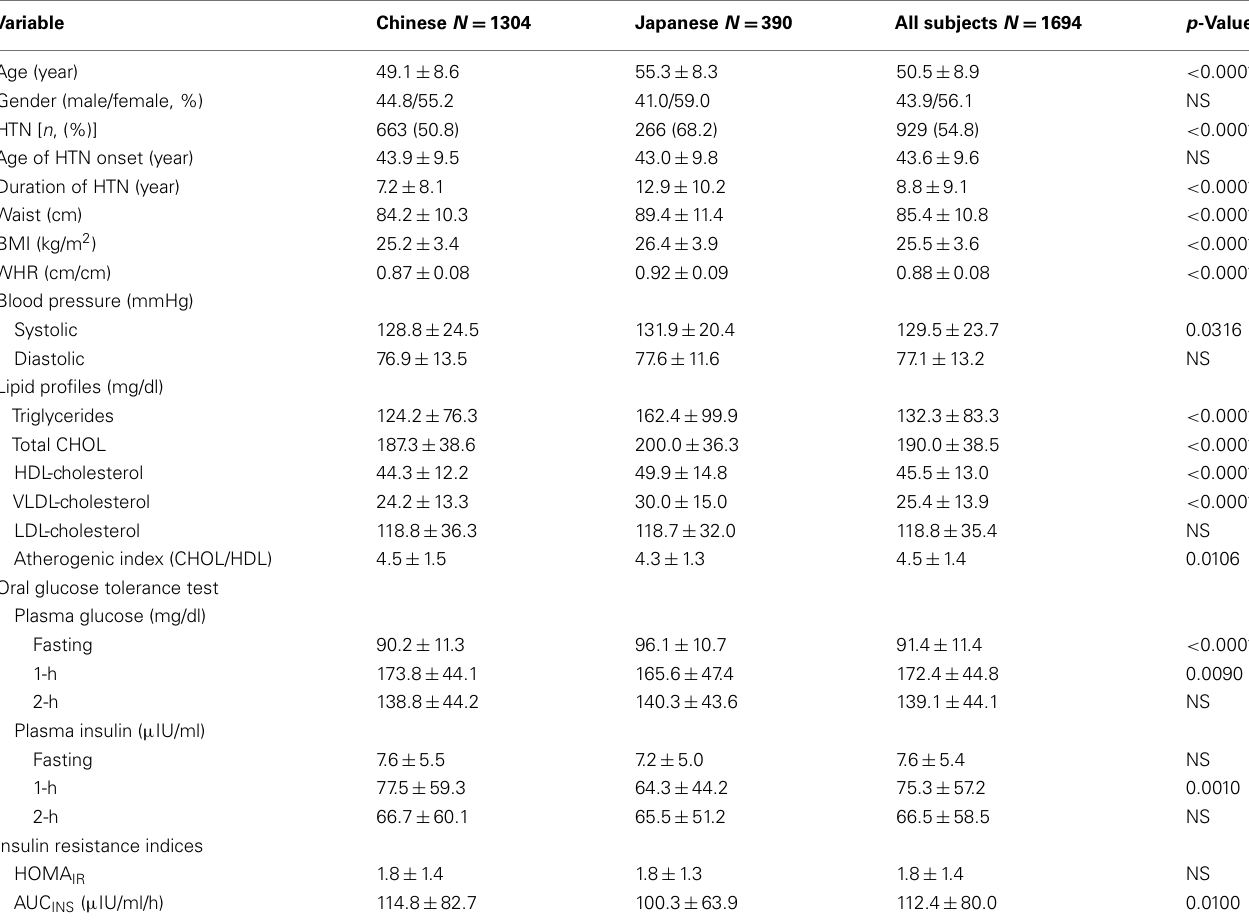
Table 1 |The anthropometric and metabolic characteristics of study population (mean ± SD) .